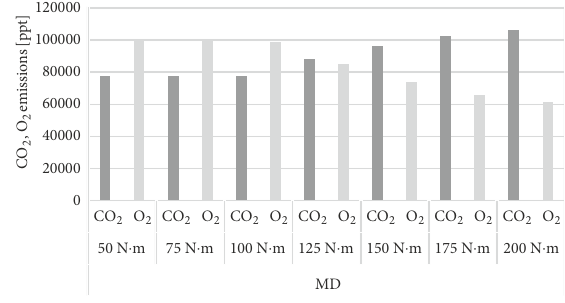
Figure 23. Emission of CO 2 and O 2 for MD sample with operating parameters of engine 3000